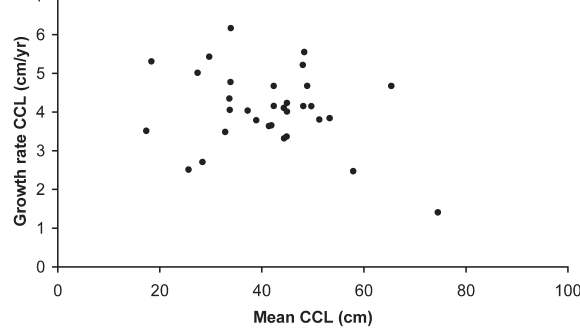
Fig . 4. – Growth rates and mean size curved carapace length (CCL) of 32 loggerhead turtles in which CCLs were back-calculated from the diameter of lines of arrested growth